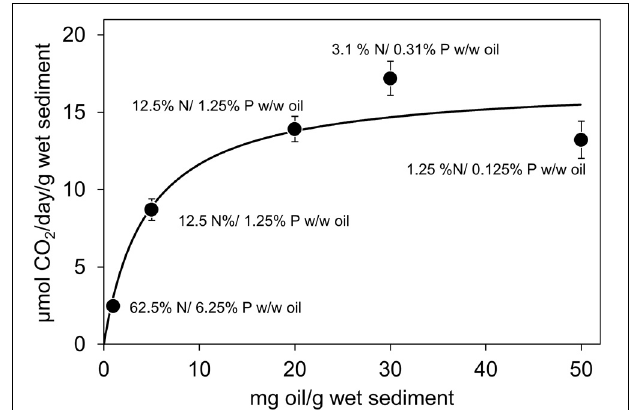
FIGURE 3 | Effect of oil concentration on the rate of CO 2 production in microcosm comprising 10g beach sediments, 6.25mg N (44.6 µ mole/g sediment) and 0.625mg P (2.02 µ mole/g sediment) and 10–500mg of North Sea crude oil. This gives a range of N and P levels ranging from 62.5% N and 6.25% P w/w of oil with 10mg of oil to 1.25% N and 0.125% P w/w of oil with 500mg of oil. With 125mg of oil this is equivalent to 5% N and 0.5% P w/w of oil. Sodium nitrate and potassium dihydrogen phosphate were used as N and P sources. Each data point represents the average value of three replicates. Where error bars are not seen they are smaller than the symbols.